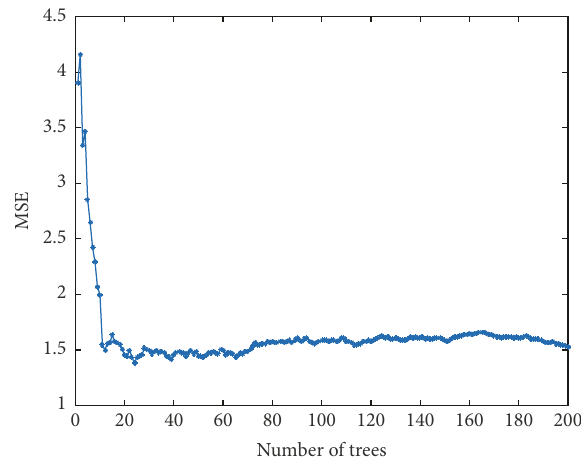
Figure 6: M5Tree model tree